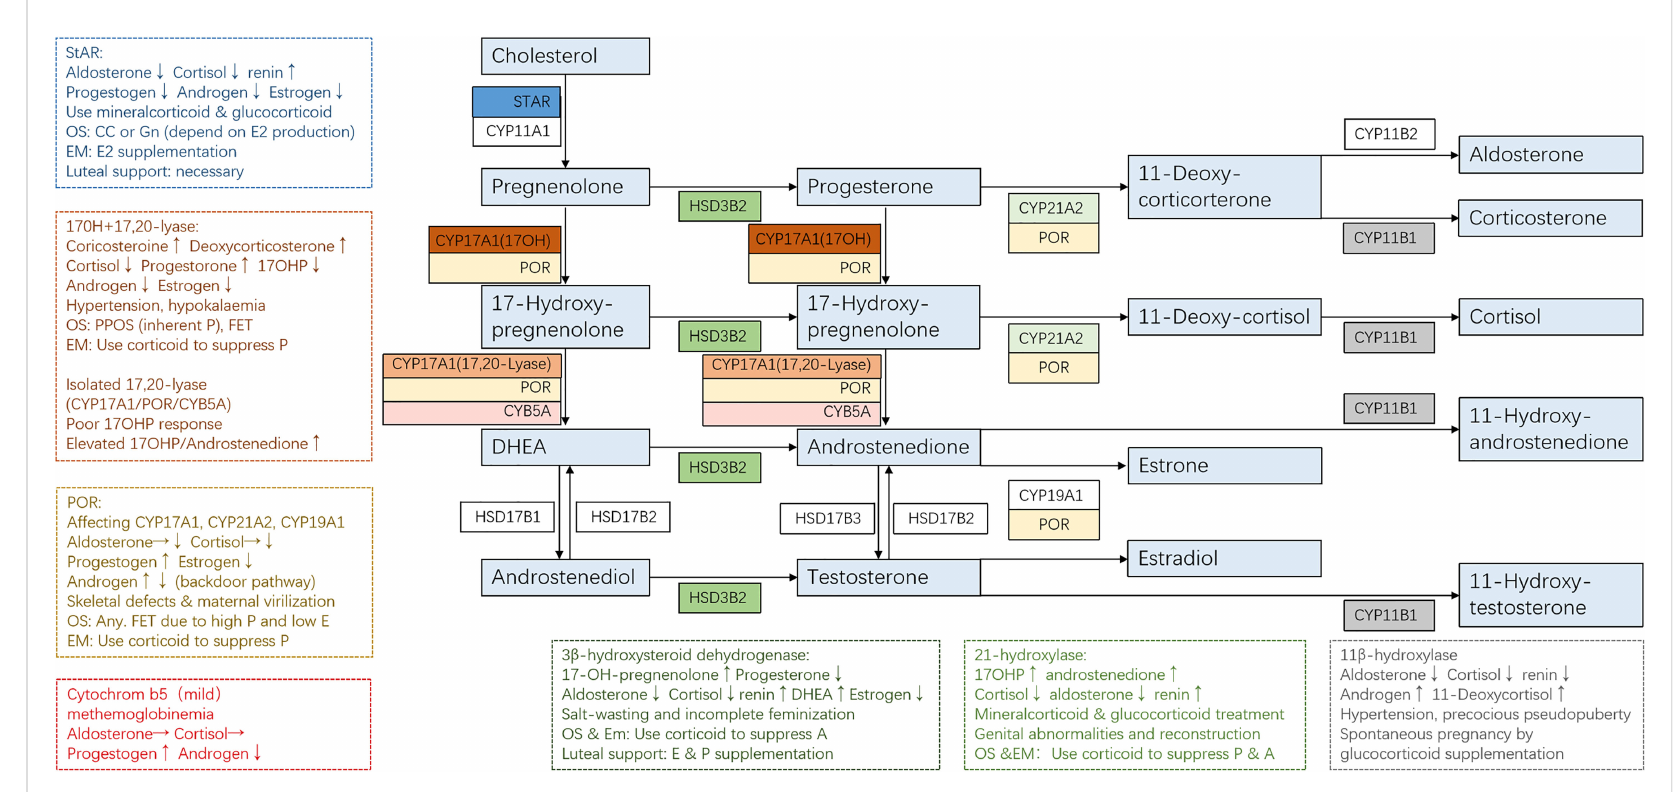
FIGURE 2 Adrenal steroidogenesis and ART use in different CAH subtypes. Clinical manifestations and corresponding protocols are summarized from case reports of pregnancies and are listed in dashed borders, but the actual situation varies from person to person. OS, ovarian stimulation; CC, clomiphene; Gn, gonadotropin; PPOS, progestin-primed ovarian stimulation; EM, endometrium preparation; FET, frozen embryo